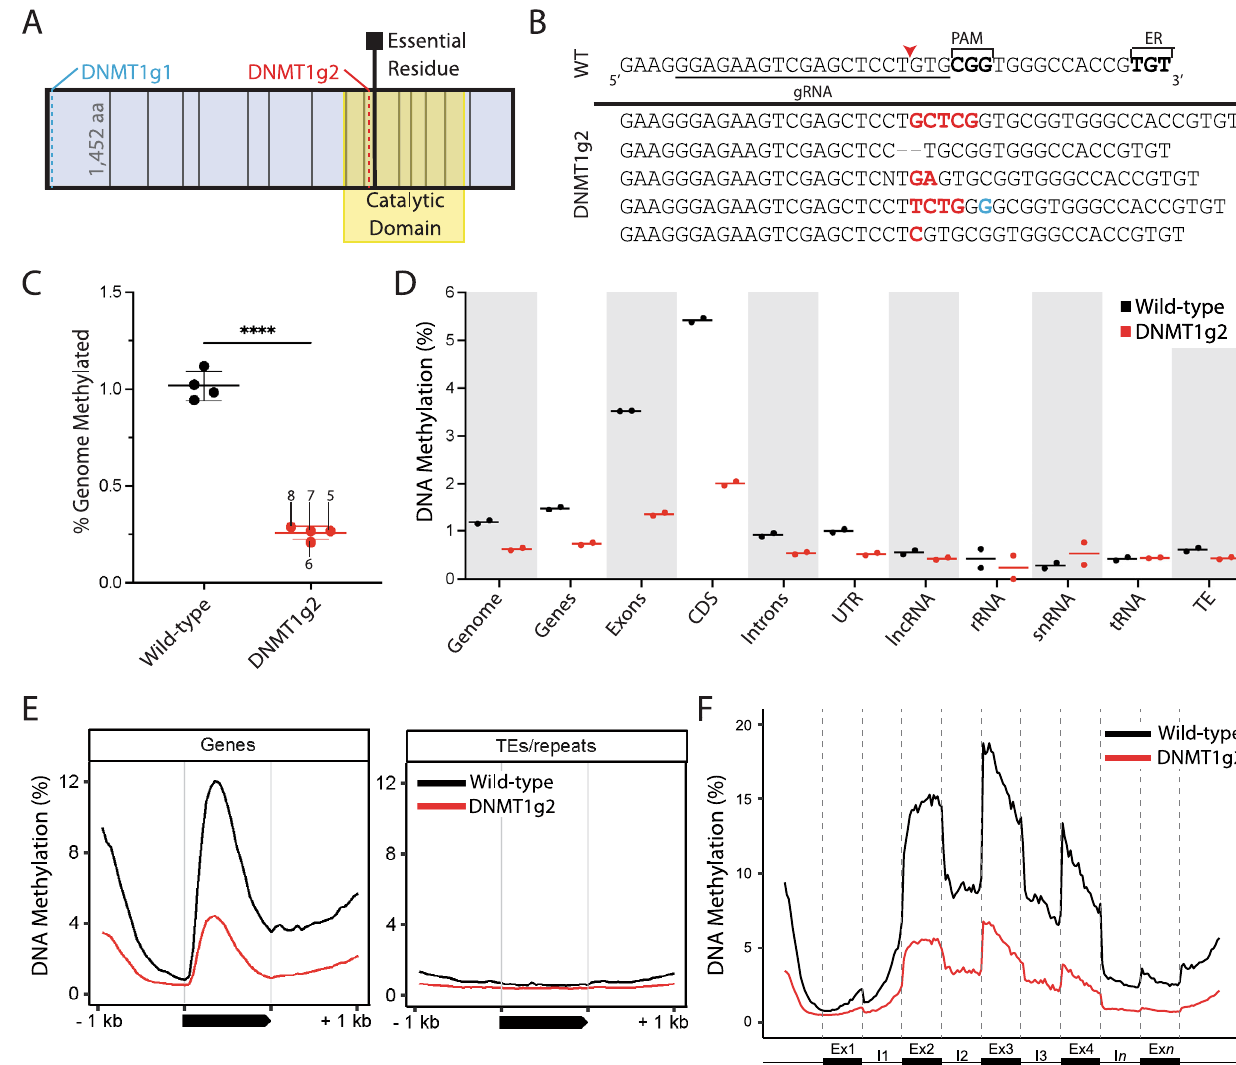
Fig. 1 | Mutations in the DNMT1 catalytic domain result in decreased DNA methylation.A ClonalraiderantDNMT1proteinmodel.Verticalsolidlinesindicate exonboundaries;brokenlinesindicateCRISPR/Cas9targetcutsites.TheDNMT1g1 (blue) targetsite is earlyinthe second exon, while the DNMT1g2 (red)target site is in the catalytic domain (yellow), upstream of an essential cysteine residue (black square). B Top: Wild-type (WT) DNMT1 sequence at the DNMT1g2 target site, with the codon for the essential residue (ER) and the protospacer adjacent motif (PAM) in bold. Guide-RNA (gRNA) sequence underlined. Red arrowhead indicates pre- dictedcutsite.Bottom:MutantallelesobservedinG0adultsshowinsertions(red), deletions (gray) and base changes (blue). C DNMT1g2 mutants have decreased genome-widemethylationcomparedtowild-typeantsrearedinparallel,consistent with a functional defect in DNMT1 (two sided unpaired T-test: p <0.0001; n =4 animalspercondition). Errorbarsshowstandard deviation around the mean. Each